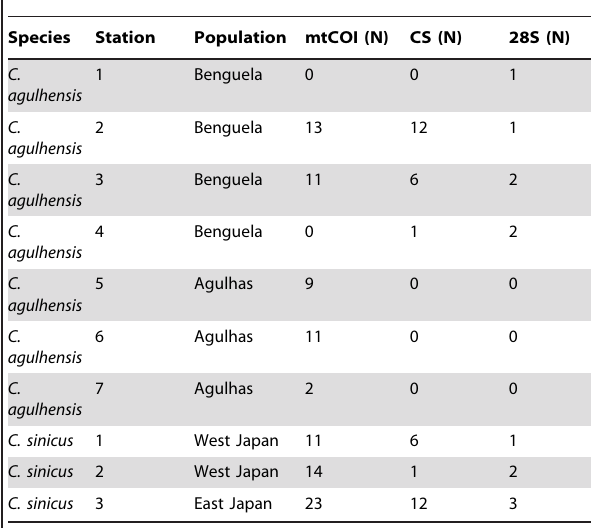
Table 2. Numbers of individuals sequenced and analyzed per sampling station